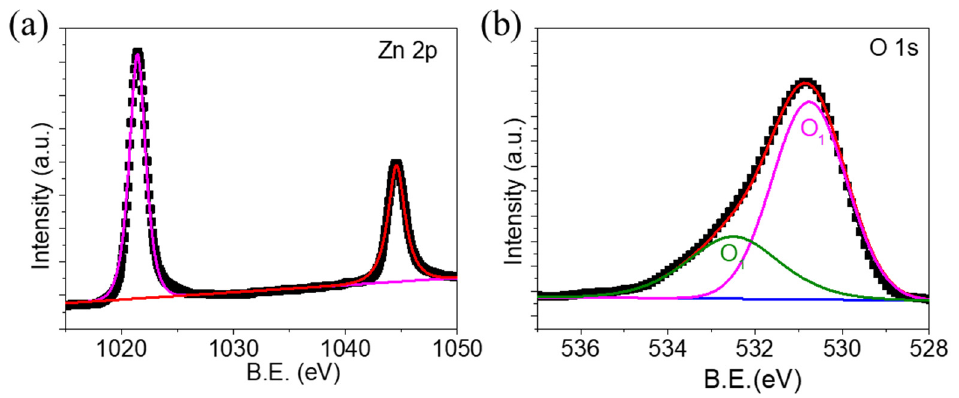
Figure 4. ( a ) Zn 2p and ( b ) O 1s core-level X-ray photoelectron spectra of ZnO nano-flowers.